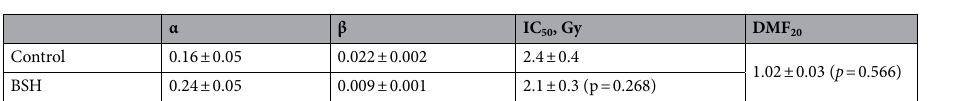
Table 1. Parameters for the linear-quadratic fit of cell viability curve Y(X) = exp (–αX–βX 2 ), irradiation dose for half-maximal inhibition of viability (IC 50 ), and dose-modifying factor for 20% survival (DMF 20 ) of Gl-Tr cells with proton irradiation alone (Control) or after incubation with 80 ppm of boron-11 (BSH) for 7 h.